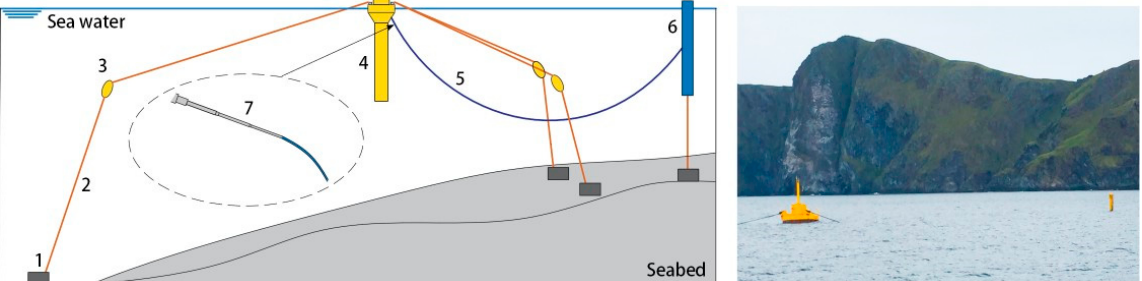
Figure 1. ( Left ) Illustration of the WaveEL 3.0 installation in Runde: (1) gravity anchor, (2) segment of a mooring line, (3) floater, (4) WEC, (5) cable, (6) hub, (7) bending restrictor, and ( right ) the full-scale WaveEL 3.0 system (photograph taken by the fourth author).